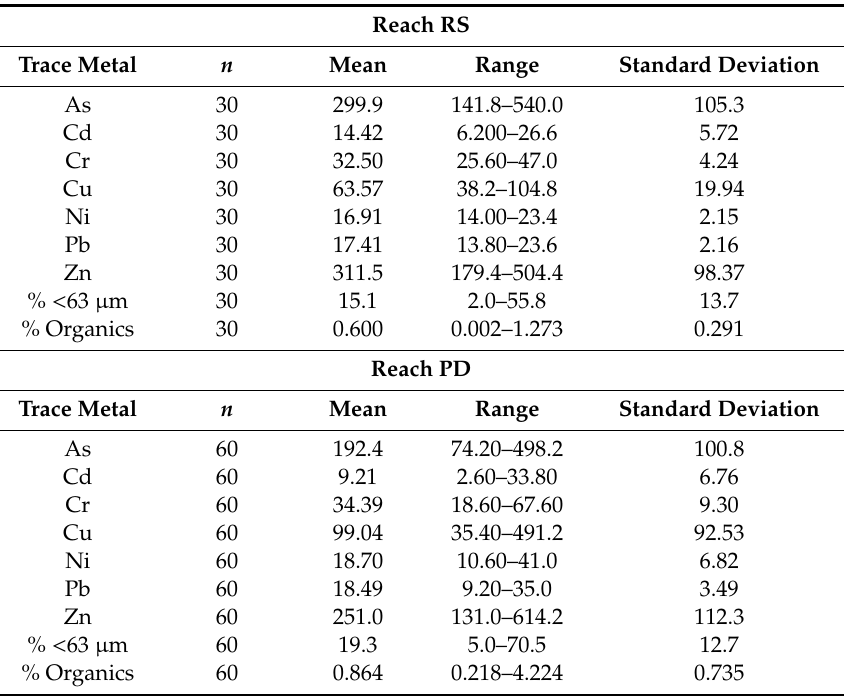
Table 2. Descriptive statistics for selected geochemical parameters measured in the fine-grained fraction by reach; values reported in mg /